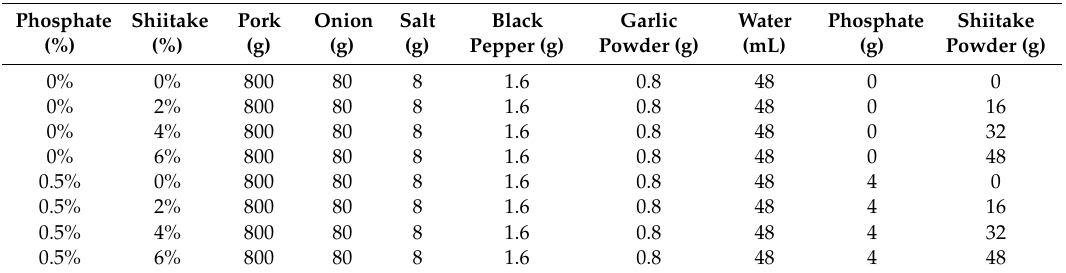
Table 1. Formulation of experimental